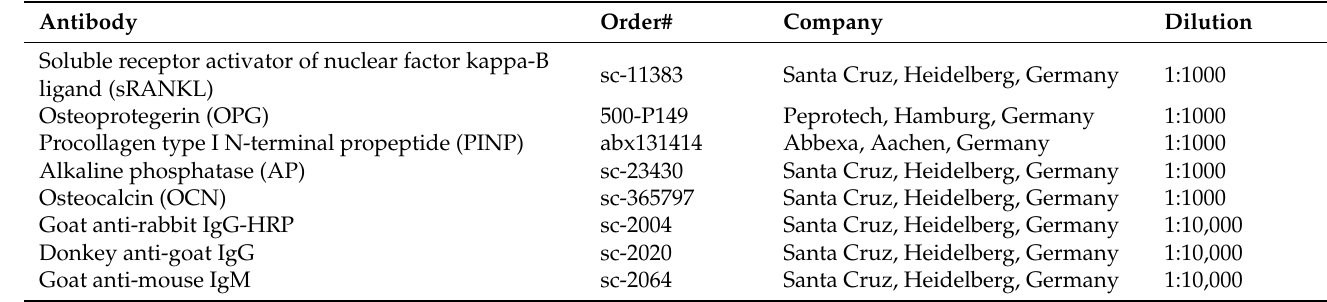
Table 2. The antibodies used for dot blot.